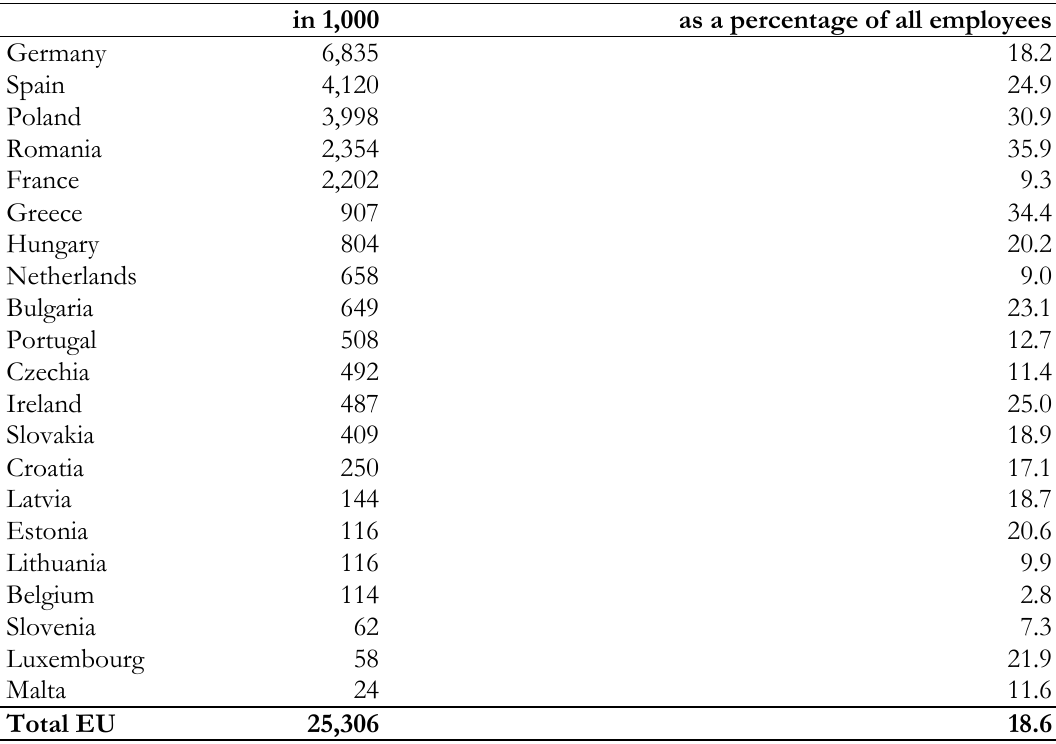
Table 1: Number of employees who would benefit from an increase in the statutory minimum wage to 60% of the median wage and 50% of the average wage* in 1,000 as a percentage of all